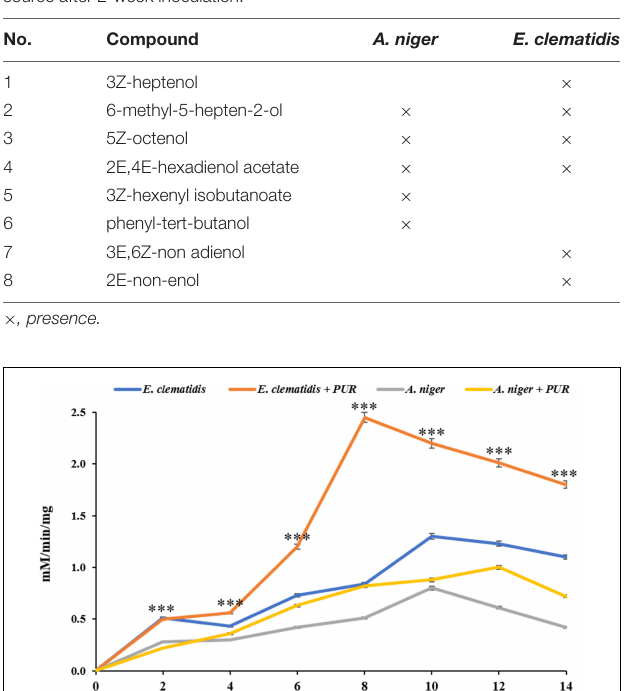
TABLE 2 | Volatile organic compounds of dichloromethane extracts E. clematidis and A. niger culture supernatants in the presence of Impranil as sole carbon source after 2-week inoculation.